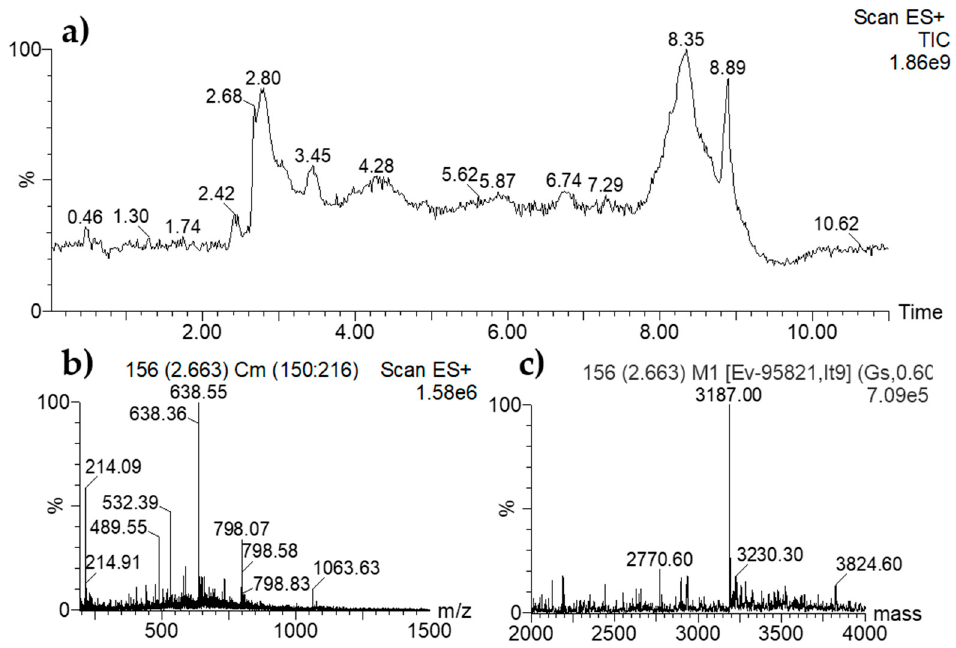
Figure 3. ( a ) UPLC-ESI-MS of crude PNA 3 after the Diels–Alder (DA)/retro-DA; ( b ) MS trace of the 2.40–5.00 min region; and ( c ) de-convoluted spectrum from the MS trace (expected MW: 3187.8). The peak present in the 8.00–9.00 min region of the UPLC-MS corresponds to a column wash step.